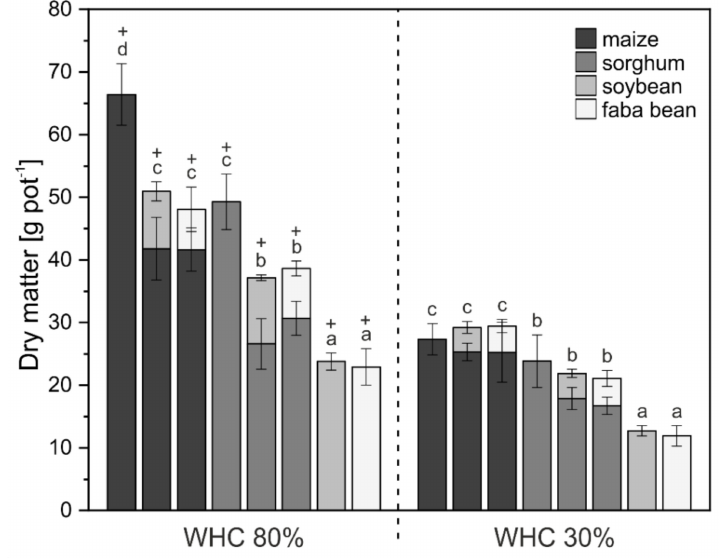
Figure 1. E ff ect of water supply on biomass (shoot dry matter) of the crops and mixtures in the Water-Trial (mean ± SD). Di ff erent letters indicate significant di ff erences between the crop variants at each water level, + indicates di ff erences between the water levels (ANOVA and Duncan’s test, p ≤ 0.05). WHC = water holding capacity.